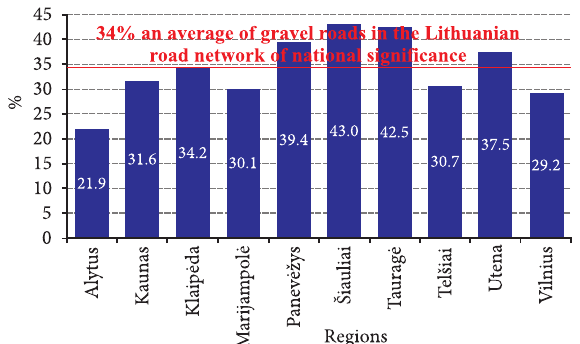
Fig. 2. Distribution of the regional roads with gravel